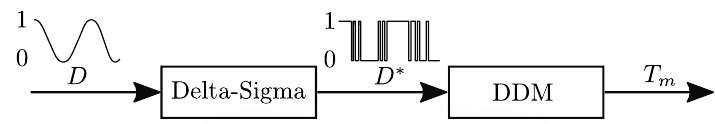
Figure 3. Schematic of the open loop control system for FSDS.